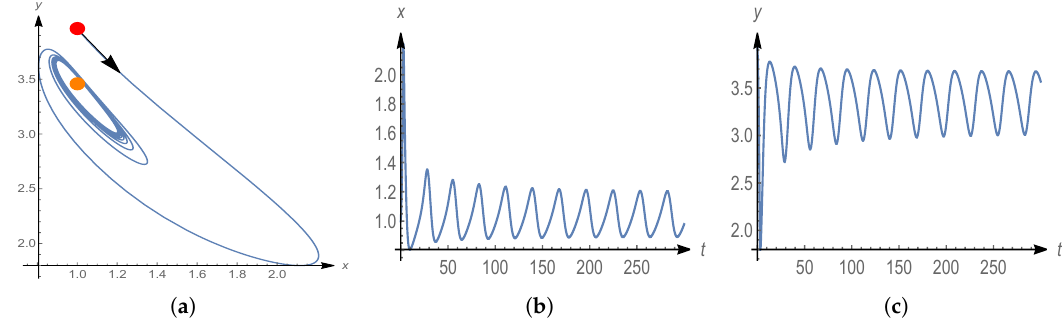
Figure 12. Model 2 with a stable outer and an unstable inner limit cycle. The trajectory is going inward, approaching the large limit cycle as t → ∞ ( d =